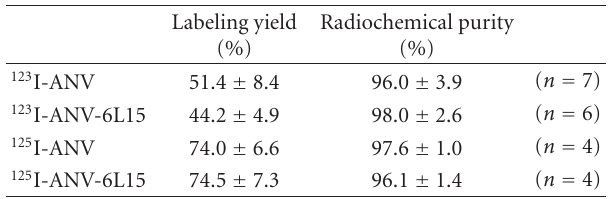
Table 1: Labeling yields and radiochemical purities of radioiodi- nated ANV and radioiodinated